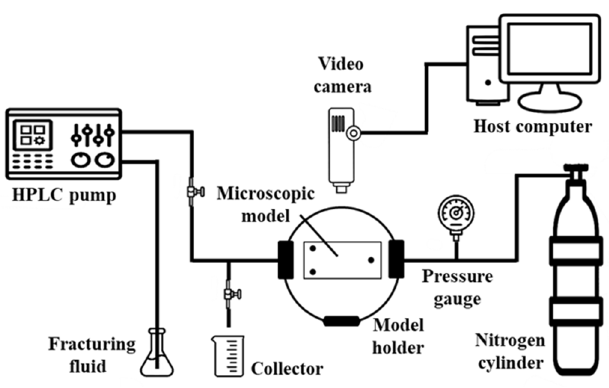
Figure 5. Schematic diagram of experiment.